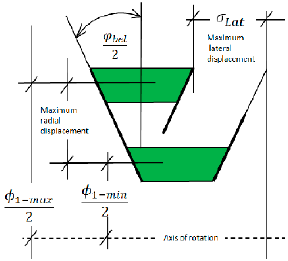
Figure 5. Lateral displacement scheme.